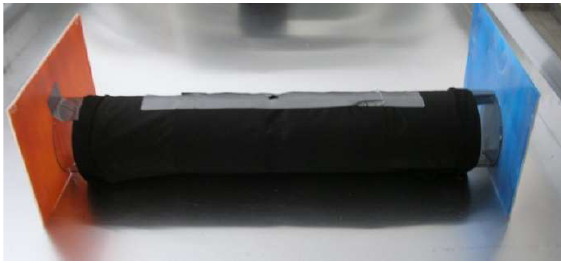
Figure 1. The experimental design for testing the response of M. galloprovincialis to color under laboratory conditions. Table 1. A list of colors tested in the laboratory and/or field